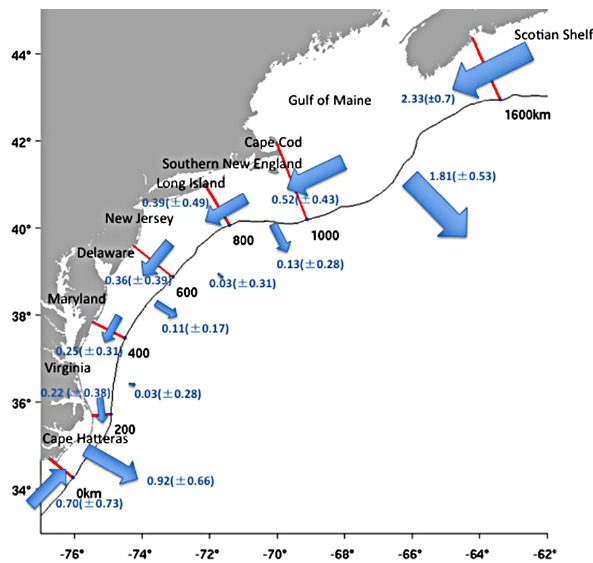
Figure 11. A schematic showing the mean circulation pattern in the MAB and GOM. The means (in Sv) and SDs (in parentheses) of transports (blue arrows) across transects in the model domain are